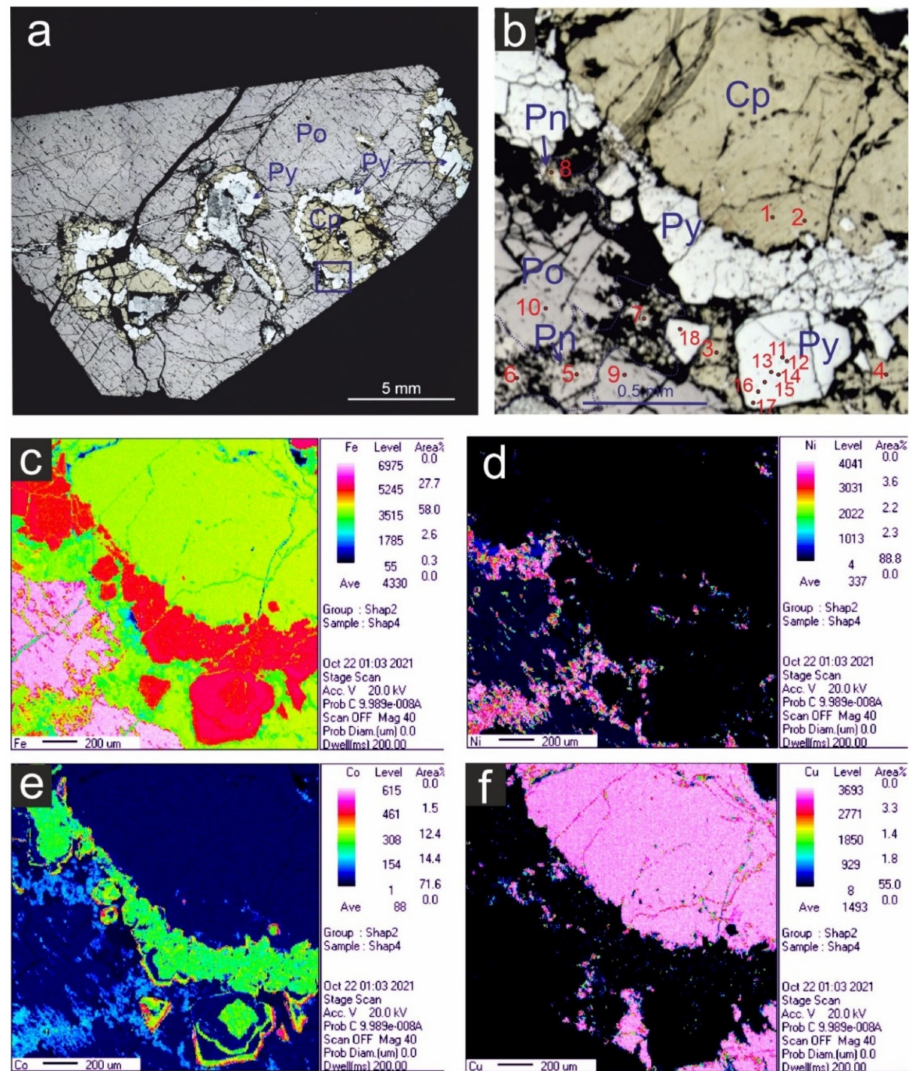
Figure 6. Polished sample mount of massive ores from borehole SF-13 ( a ), site of study within this sample—selected area for elemental maps ( b ), and EDS elemental distribution maps of the designated site of study: Fe ( c ), Ni ( d ), Co ( e ), and Cu ( f ). Points and numbers in ( b ) correspond to the analysis number shown in Table 2. Abbreviations: Py—pyrite, Po—pyrrhotite, Cp—chalcopyrite,